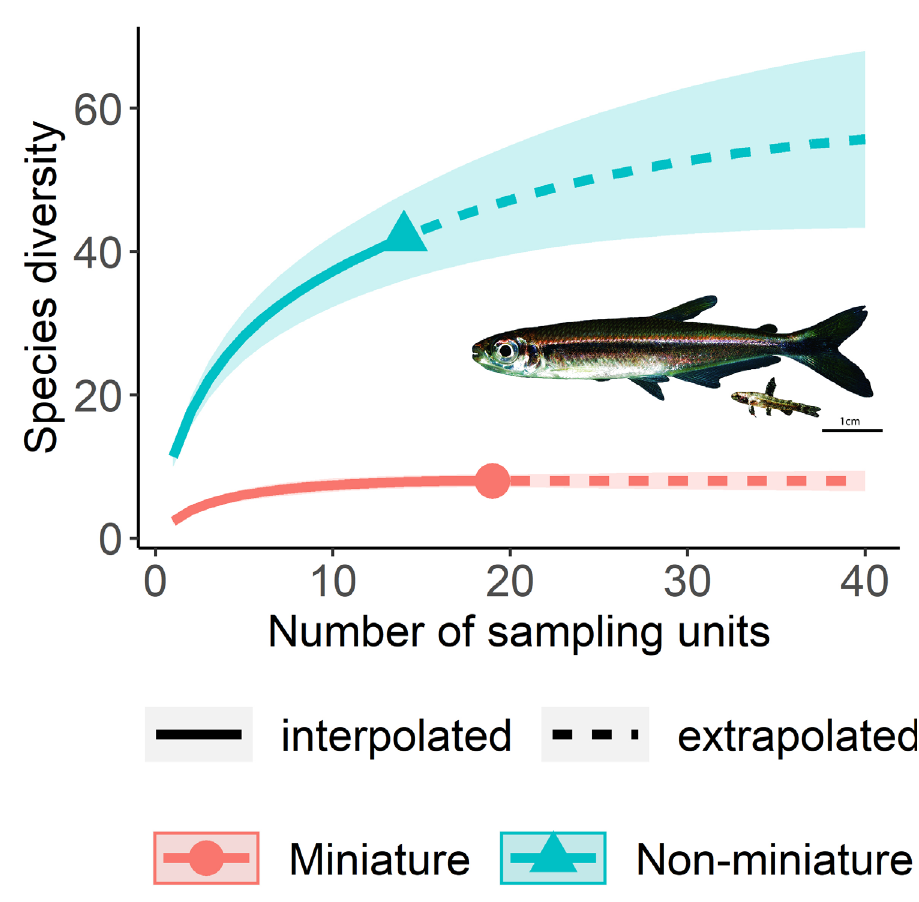
FIGURE 2 | Accumulation (solid lines), extrapolation (dashed lines), and 95% confidence intervals (shaded areas) for diversity of miniature (red) and non-miniature (blue) freshwater fishes collected from the rio Jacundá, rio Amazonas basin, Brazil.